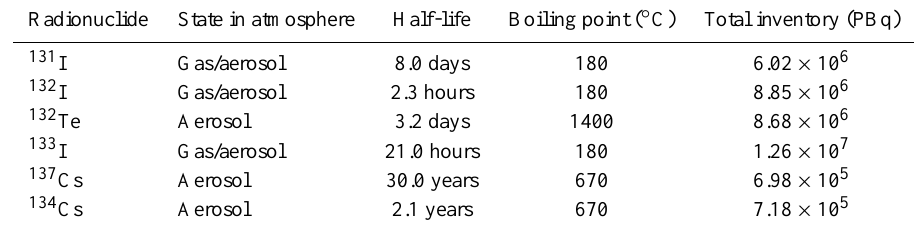
Table 5. Characteristics and total inventories of radionuclides for Units 1–3 at FNPS1 (Nishihara et al.,